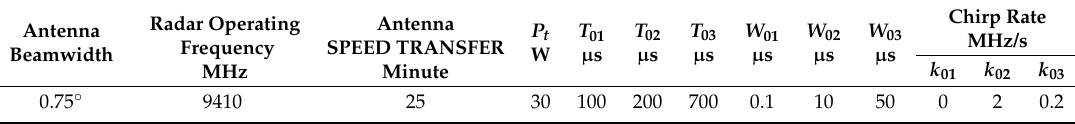
Table 6. Radar main operating